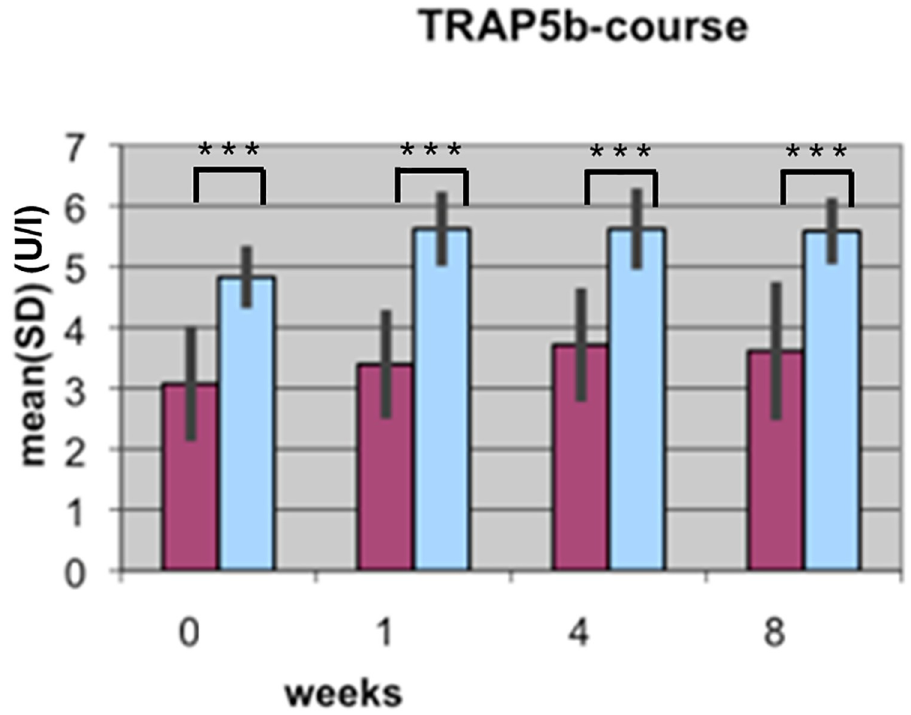
Fig 4. Course of TRAP5b serum concentration (U/l) during fracture healing of eight weeks in low BMD versus normal BMD patients. (Dark bars: low BMD group, light bars: normal BMD group). Statistics were performed using the software SPSS 11.0.0 (IBM Germany, Munich, Germany), Friedman test, Wilcoxon rank test and Mann-Whitney U tests were used. P � 0.05 was considered to be significant, p � 0.01 as very significant, and p � 0.001 as highly significant. Different levels of significance are marked by one to three